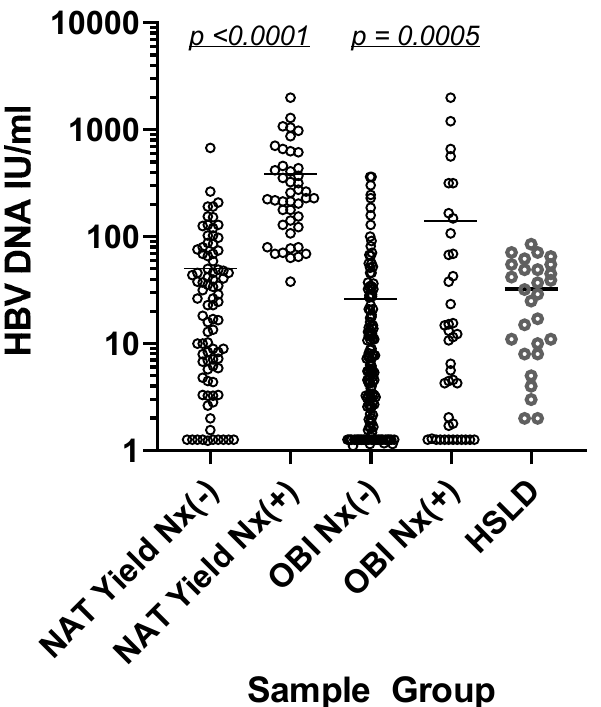
Figure 1. HBV DNA levels in NAT yield, OBI, and HSLD samples: HBsAgNx-negative NAT yield (N = 87), HBsAgNx-positive NAT yield (N = 44), HBsAgNx-negative OBI (N = 146), HBsAgNx- positive OBI (N = 42), HSLD (N = 28). Samples with HBV DNA levels below the quantification range were assigned the value of 0.1 log IU/mL (1.26 IU/mL) for the purpose of analysis. Mean values are indicated by bars.